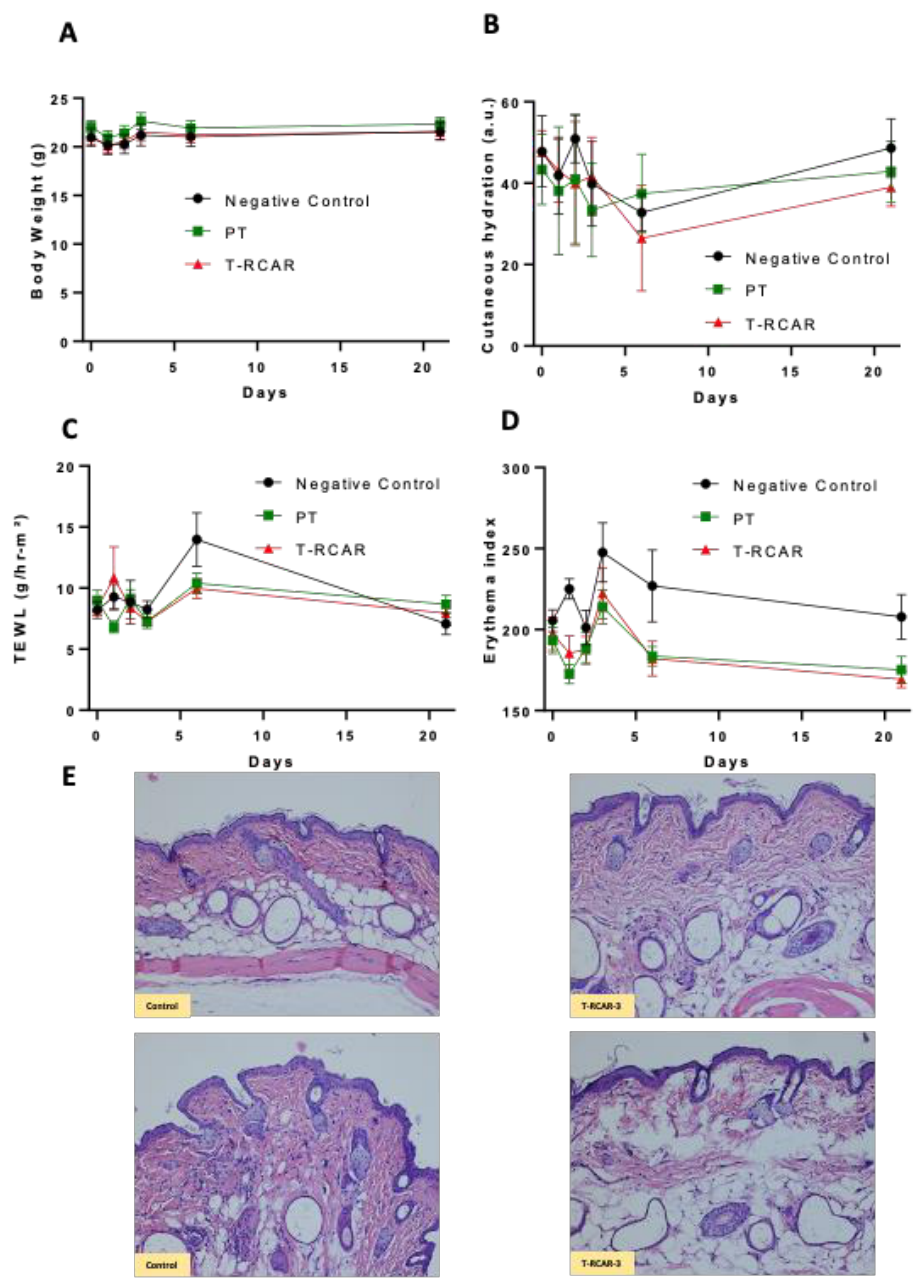
Figure 6. In vivo dermal toxicity test (repeated dose). ( A ) Body weight of mice was measured one day before, and on days 1, 2, 3, 6, and 21 after daily T-RCAR gel topical treatment (100 µ M R-carvedilol). ( B ) Cutaneous hydration levels as measured with the corneometer one day before, and days 1, 2, 3, 6, and 21. On day 6, T-RCAR showed reduced hydration in 4 out of 6 mice < 30, indicating skin dryness, but recovered at 3 weeks. ( C ) Transepidermal water loss (TEWL) for skin barrier function, measured by the Tewameter one day before, and days 1, 2, 3, 6, and 3 weeks after T-RCAR topical treatment was initiated; TEWL < 25: normal condition. ( D ) Mexameter was used to measure erythema, one day before, and days 1, 2, 3, 6, and 3 weeks after T-RCAR topical treatment was initiated; <330: minimal erythema. Sample size: n = 4 for control; and n = 6 for PT or T-RCAR. Statistical analysis was based on repeated measures ANOVA. For most parameters, there was no significant difference between the three groups, except the erythema index, where the control group showed a slightly increased erythema. ( E ) Representative H&E-stained images for skin tissues collected from control mice and T-RCAR-3-treated